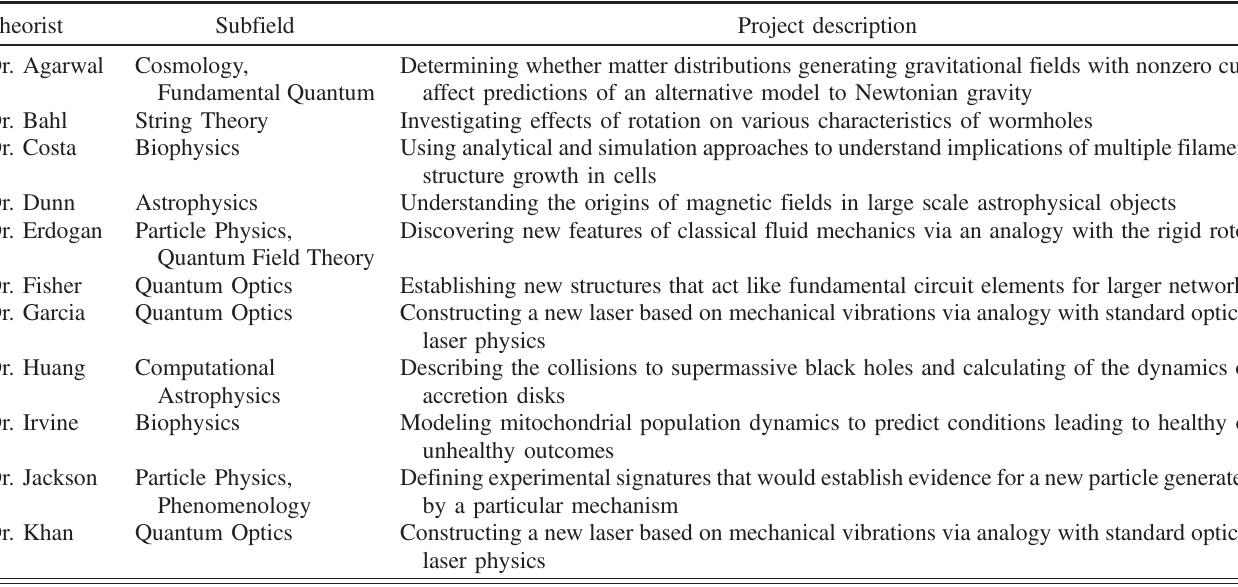
TABLE II. Table of theorists ’ subfield and a description of the research projects they described in their interviews. Of the N ¼ 11 total participants, N ¼ 6 verbally described their gender as “ male, ” N ¼ 2 “ female, ” and N ¼ 3 as a “ woman. ” The institutions that the theorists represented included a small undergraduate liberal-arts college, two large public 4-year universities, and two large private